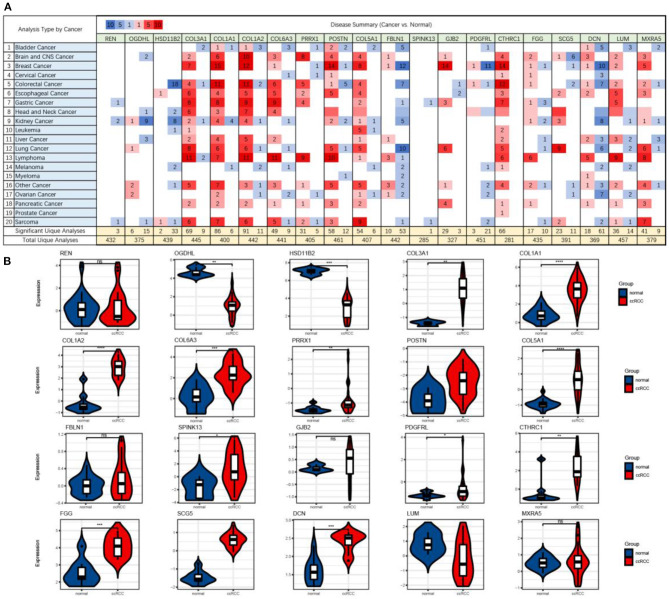
The mRNA expression levels (cancer vs. normal) of shared DEGs in multiple cancer types (A) and ccRCC (B), which were based on ONCOMINE. The figure shows the numbers of datasets with statistically significant upregulated (red) and downregulated (blue) mRNA expression.